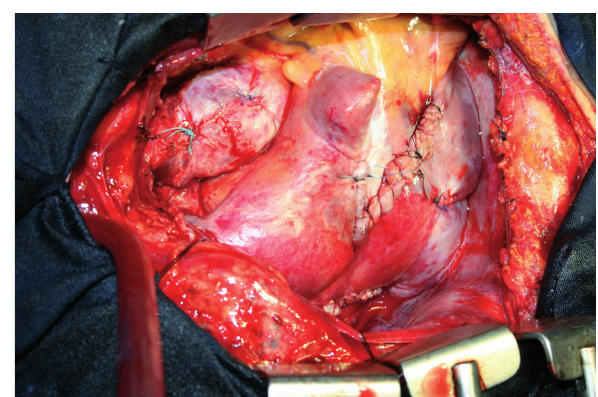
Fig. 6 - Aspecto final do procedimento após saída de CEC